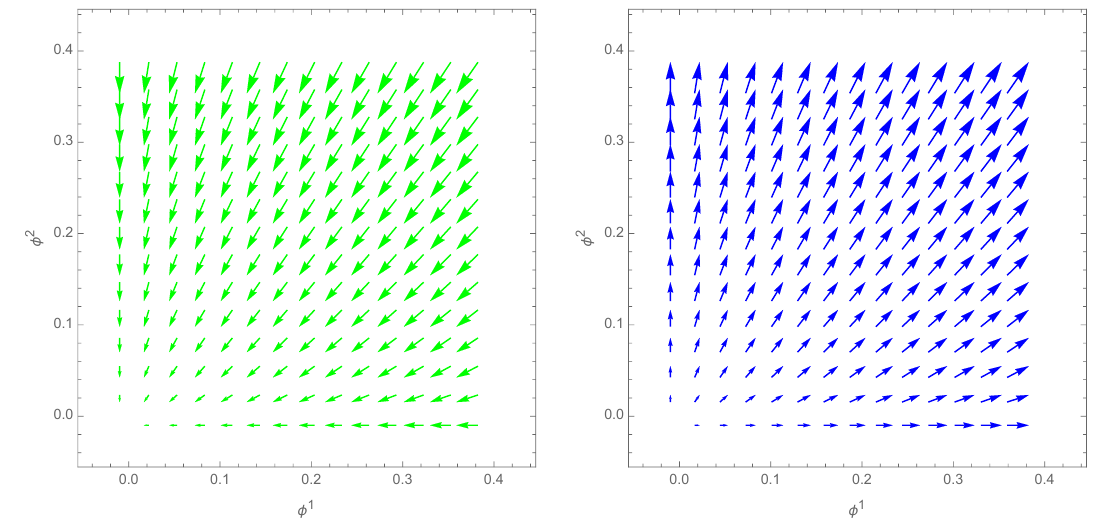
Figure 6 . The gradient of the superpotential given by equation (3.61) and depicted in (cid:12)gure 5. The velocity (cid:12)eld focus on the point (cid:30) = (cid:30) B = 0. The fact that the W ( (cid:30) ) cannot be continued for negative (cid:30) r (cid:0) (cid:30) r , as follows from (3.61) and from the signs of @ r V j (cid:30) B problem since the paths this superpotential generates do not cross the lines (cid:14)(cid:30) 1 = 0 and (cid:14)(cid:30) 2 =